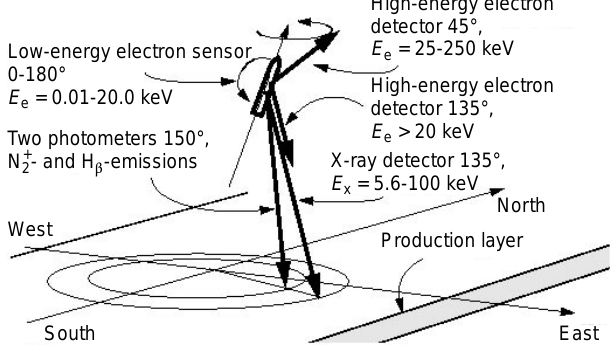
Fig. 1. Geometry of the observations and orientation of the instruments on board the rocket; the X-ray production layer